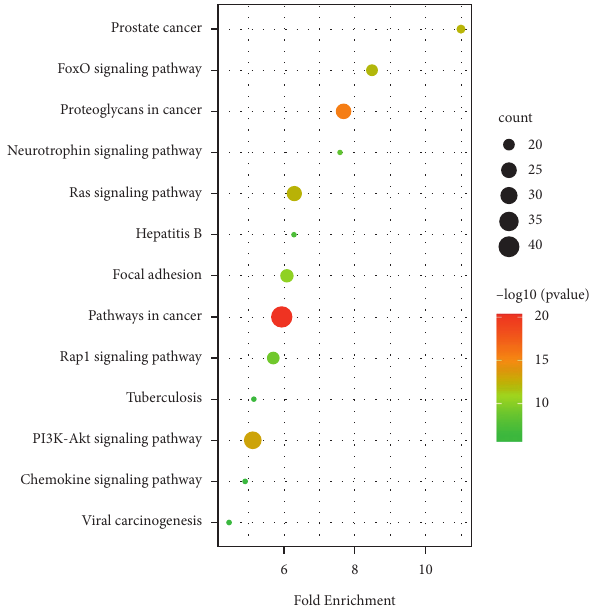
Figure 13: Enrichment analysis of KEGG pathway of the top 13 key targets.